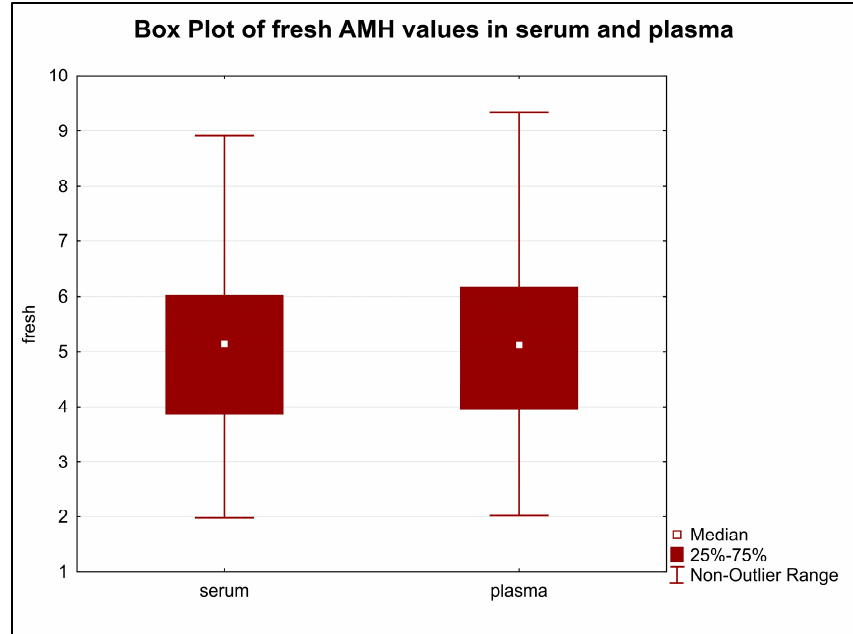
Figure 1. The difference in the distribution of initial AMH values in serum and plasma. Legend: The distribution of the values in serum and plasma samples were very similar and showed no statistically significant difference ( p = 0.8858).